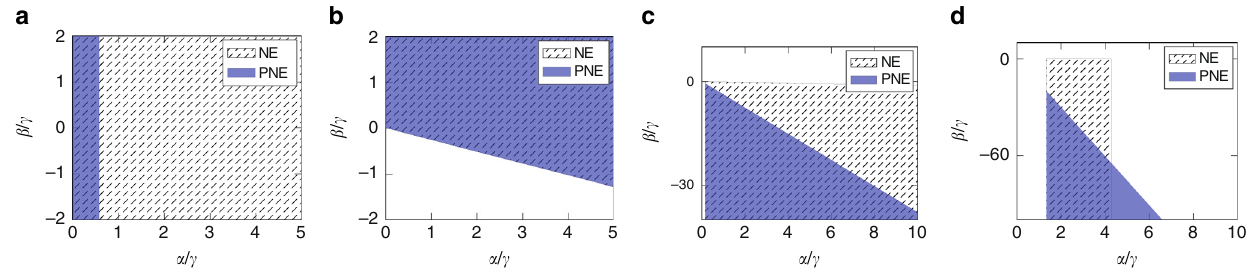
Fig. 4 NE and PNE regions of the four network motifs of homogeneous agents. a Empty, b Complete, c Balanced Complete Bipartite, d Star Network. All the plots refer to N ¼ 50 agents and δ ¼ 0 : 5. Different settings lead to qualitatively similar